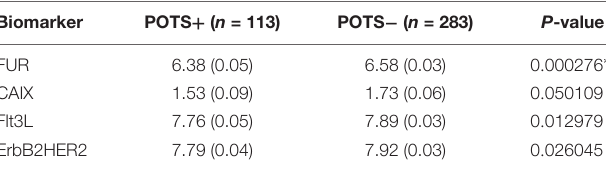
regression was performed for each of the 48 biomarkers.